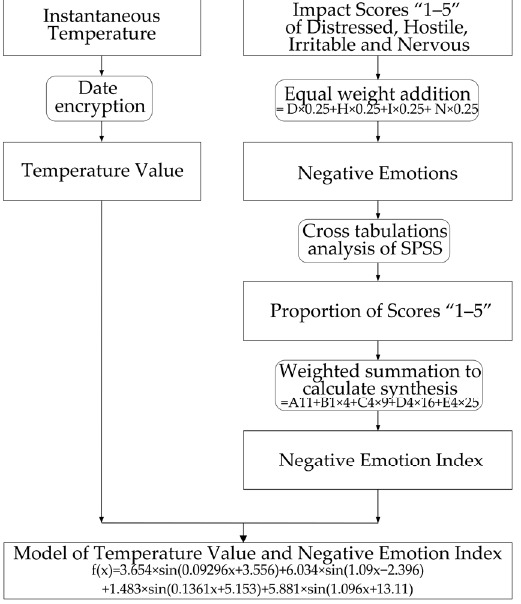
Figure 4. Flowchart for building the model of temperature value and negative emotion index. The trend of the negative emotion index affected by daily average temperature was calculated using the linear trend estimation method [58]. The daily average temperature was obtained by averaging the hourly temperatures of the Chinese meteorological stations. The mean value of the negative emotion index was obtained by substituting the hourly temperature into the model (4). Finally, a fitting curve equation of the daily aver- age temperature and negative emotion index was established (Figure 5), with R 2 = 0.97